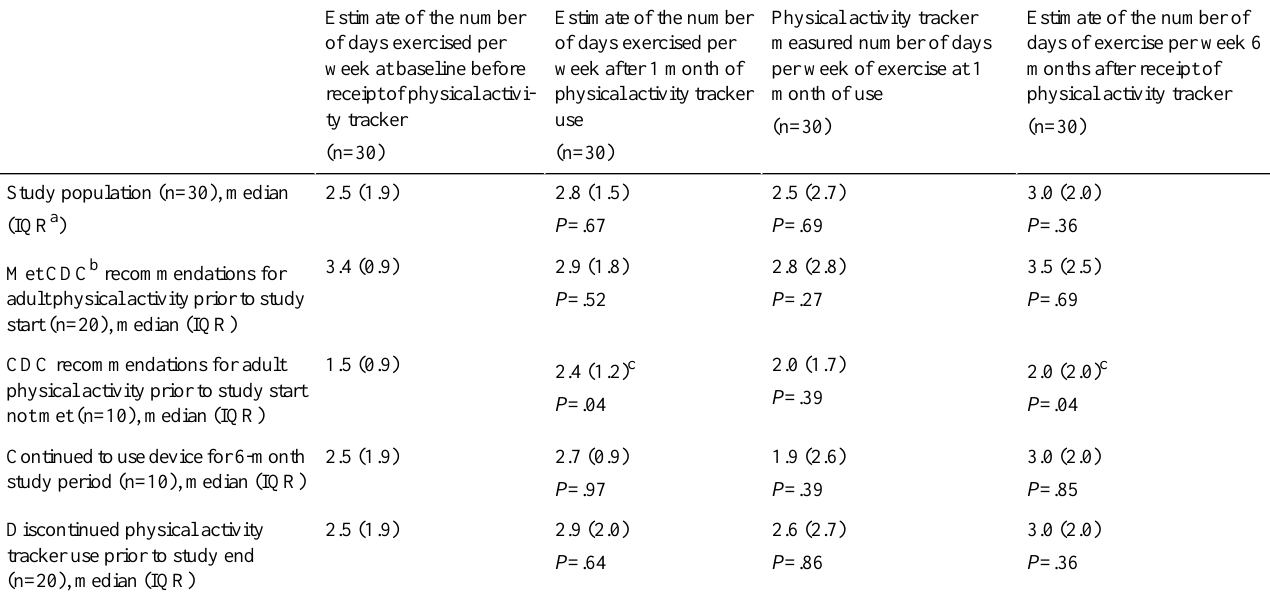
Table 2. Self-reported physical activity among study participants at baseline, 1 month, and 6 months stratified by continued use and by level of physical activity before receiving device.